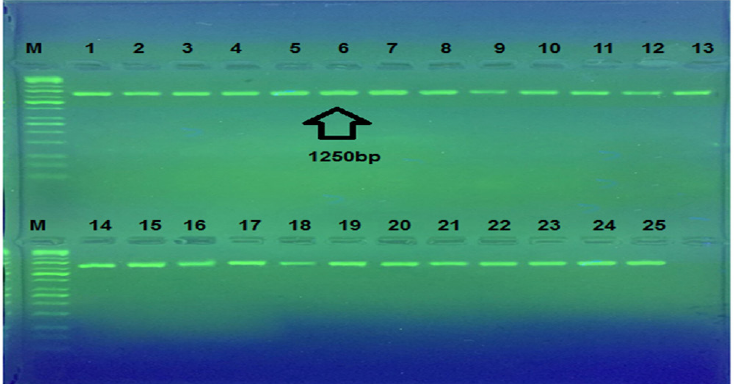
Fig. 1. Agarose gel electrophoresis for 16SrRNA gene (1250bp) amplification of Staphylococcus aureus . electrophoresis on a 2% agarose gel and visualized under U.V. light after staining with red safe staining. Lane: 1 (M: 100bp ladder), Lane: 1to 25 product PCR positive.